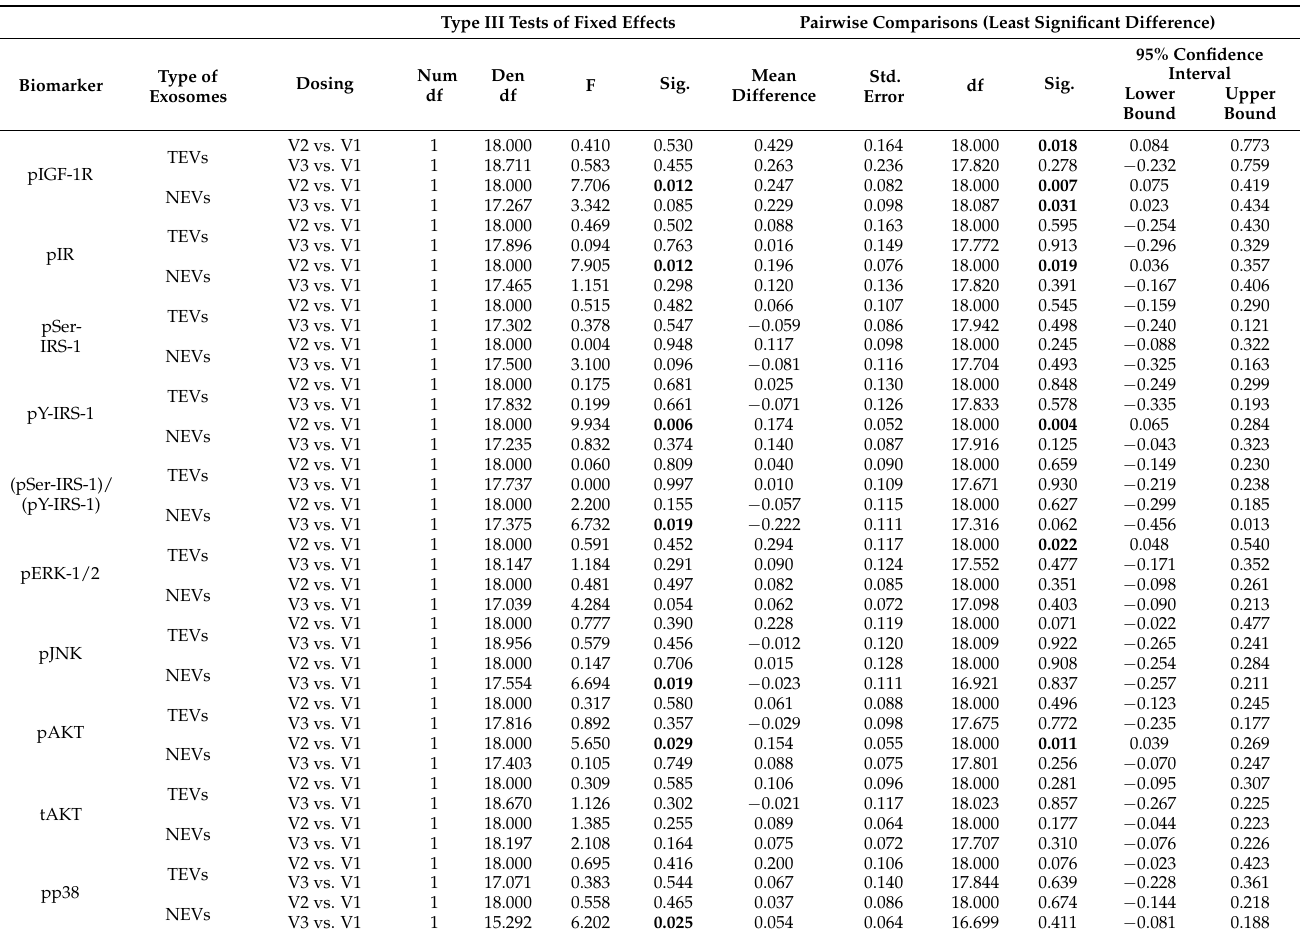
Table 3. IGF-1/insulin cascade-associated proteins measured in total EVs (TEVs) and EVs enriched for neuronal origin (NEVs) at baseline (V1), after one dose (V2), and after multiple (V3) empagliflozin doses.